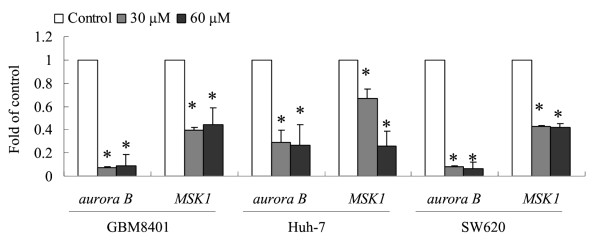
Squamocin decreased expression levels of RNA of aurora B and MSK1. GBM841, Huh-7 and SW620 cells were incubated with 30 and 60 μM squamocin for 24 h. mRNA was extracted and detected by qRT-PCR. Data represent fold change versus controls, and values were normalized to GAPDH. Data are the mean of three independent experiments. * p < 0.05, compared to the control.